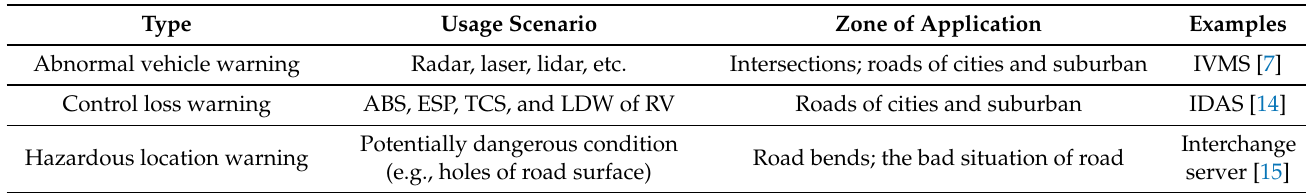
Table 3. Three types of abnormal information